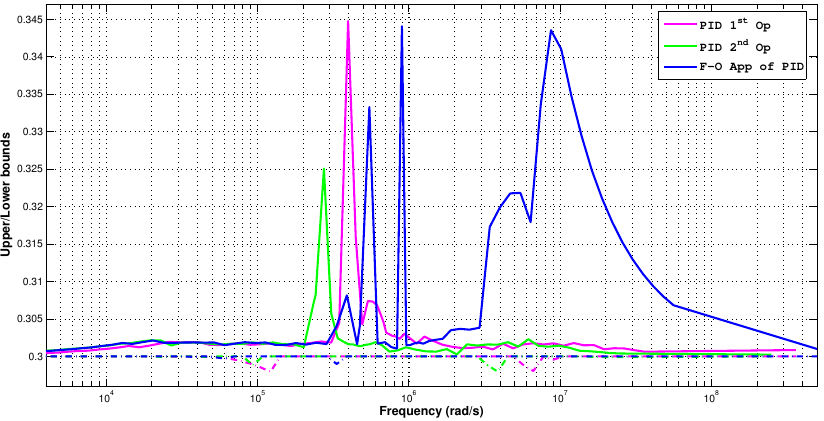
Figure 11. Upper (solid lines) and lower (dotted lines) bounds of the structured singular value µ ∆ to determine robust stability margins of the closed-loop